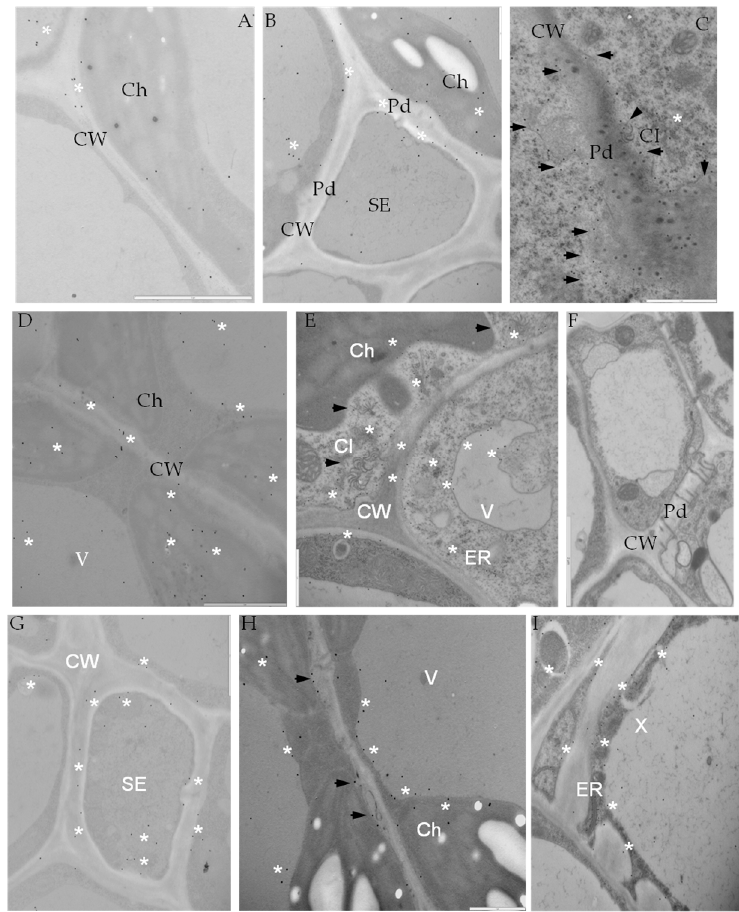
Figure 4. Immunogold labeling of PR-2 in potato-PVY NTN compatible ( B – E ) and incompatible interaction ( F – I ). ( A ) Gold deposition in mesophyll of mock-inoculated leaf. Bar 2 µ m. ( B ) PR-2 deposition in sieve elements in potato Irys inoculated with PVY NTN . Bar 1 µ m. ( C ) PR-2 deposition in